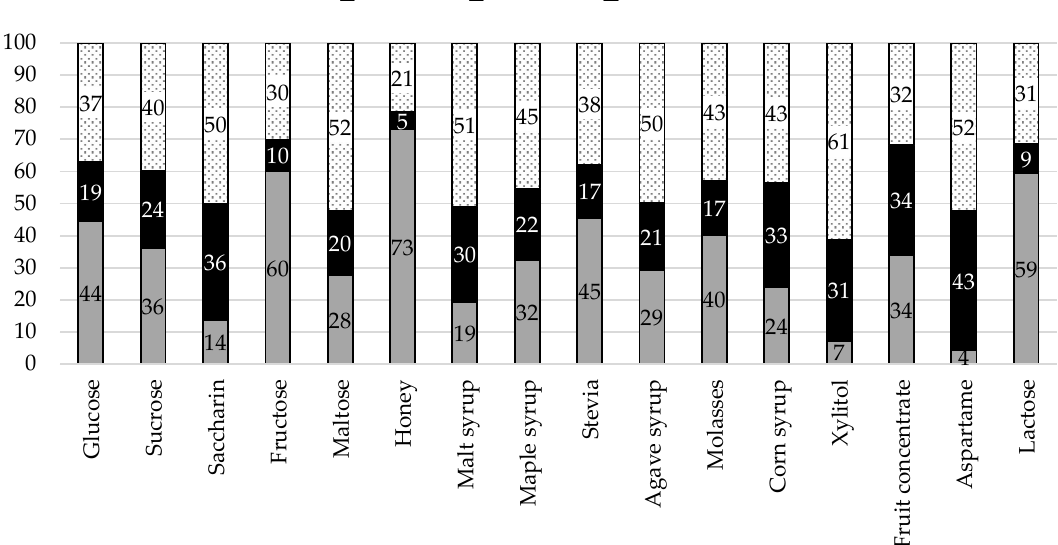
Figure 4. Categorization of sugar sources according to origin.